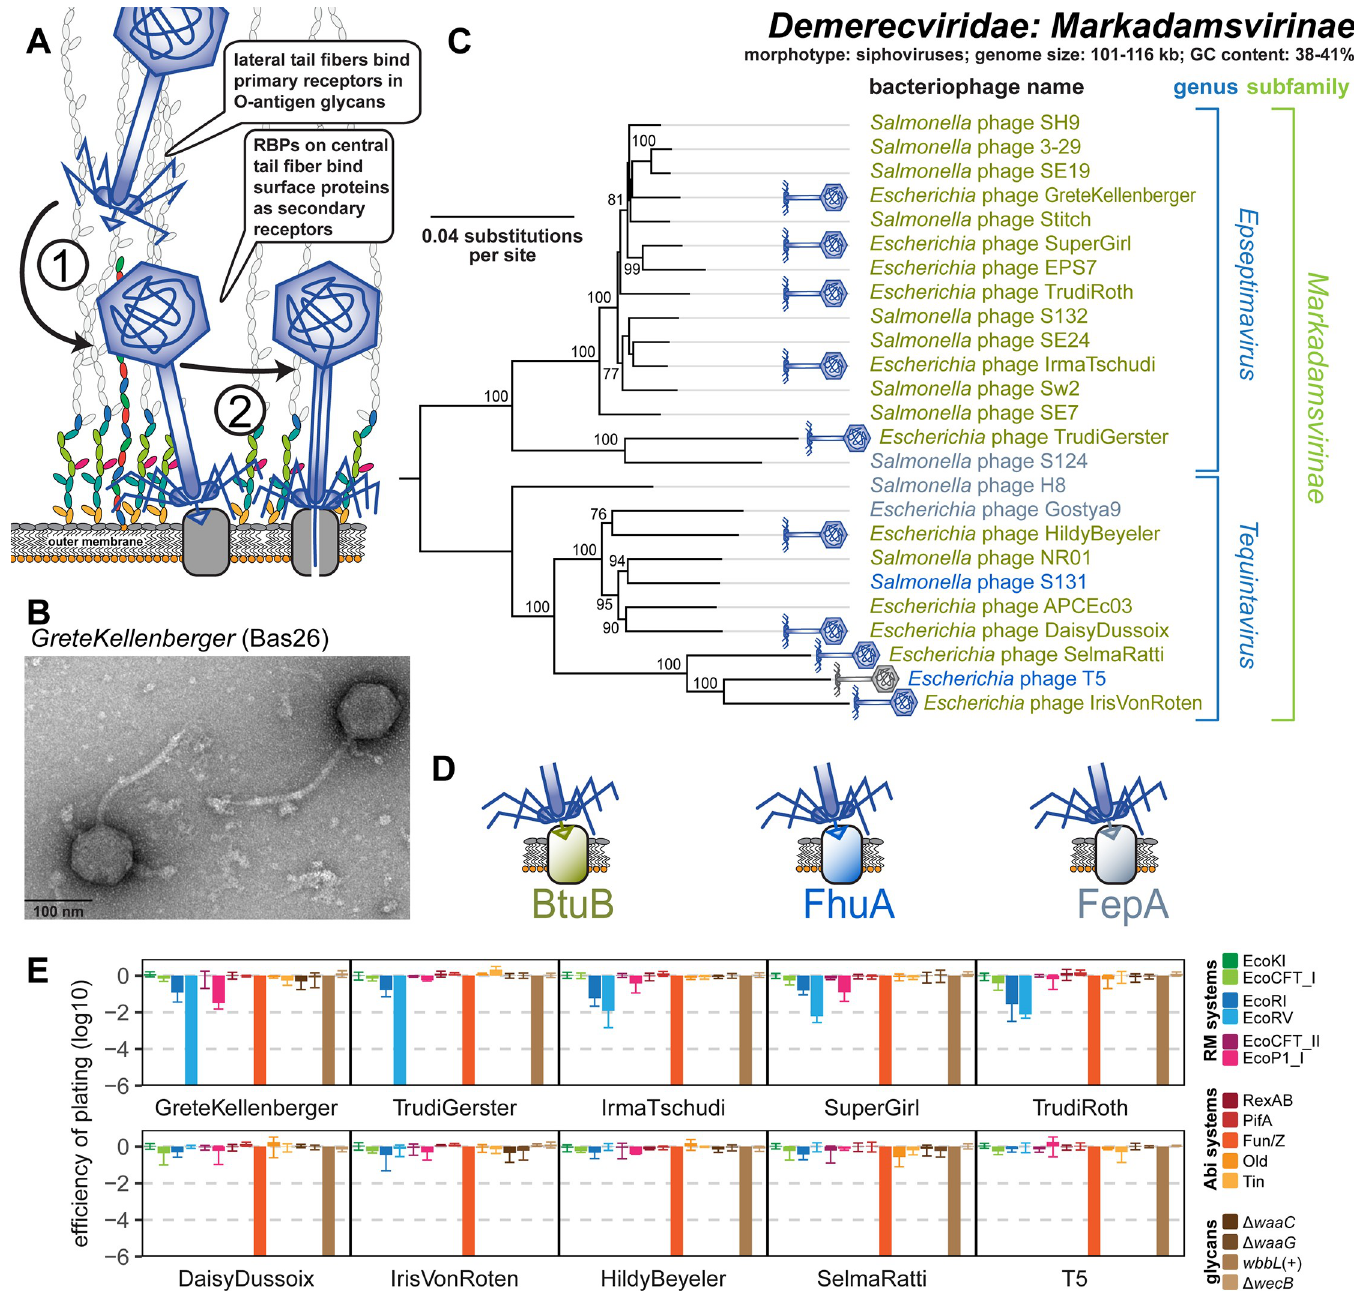
Fig 6. Overview of Demerecviridae subfamily Markadamsvirinae. (A) Schematic illustration of host recognition by T5-like siphoviruses. (B) Representative TEM micrograph of phage GreteKellenberger (Bas26). (C) Maximum-Likelihood phylogeny of the Markadamsvirinae subfamily of Demerecviridae based on several core genes with bootstrap support of branches shown if > 70/100. Phages of the BASEL collection are highlighted by little phage icons, and the determined or proposed terminal receptor specificity is highlighted at the phage names using the color code highlighted in (D). The phylogeny was rooted between the Epseptimavirus and Tequintavirus genera. (D) Color code of terminal receptor specificity (same as in Figs 3–5). (E) The results of quantitative phenotyping experiments with Markadamsvirinae phages regarding sensitivity to altered surface glycans and bacterial immunity systems are presented as EOP. Data points and error bars represent average and standard deviation of at least 3 independent experiments. Raw data and calculations are available in S1 Data. Abi, abortive infection; BASEL, BActeriophage SElection for your Laboratory; EOP, efficiency of plating; RBP, receptor-binding protein; RM, restriction–modification; TEM, transmission electron microscopy.